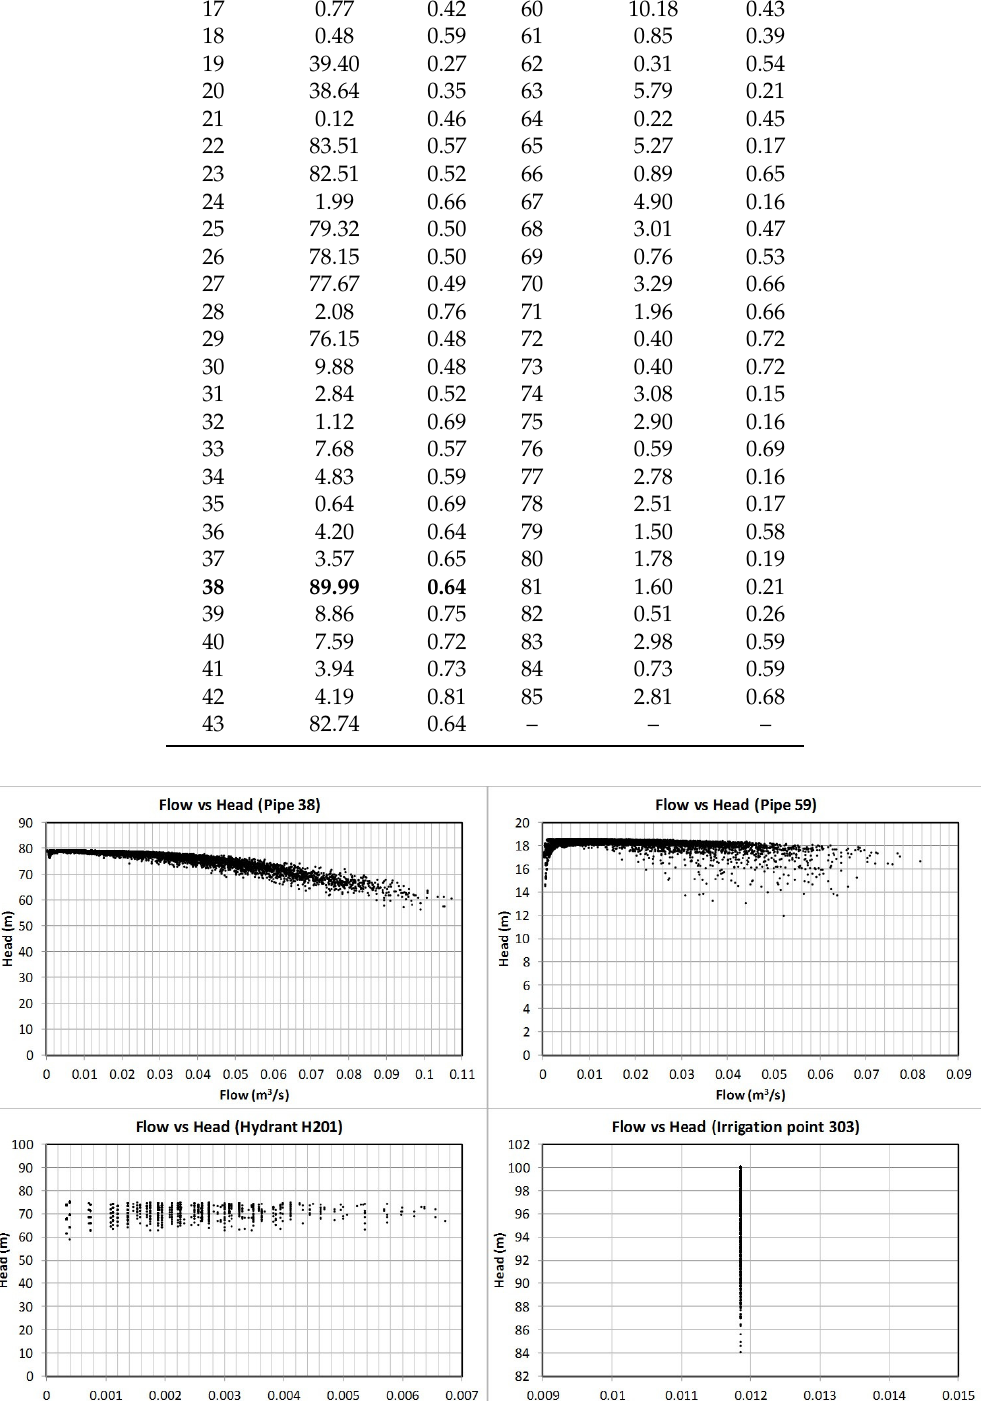
Figure 21. Annual Balance Energy in hydrants.